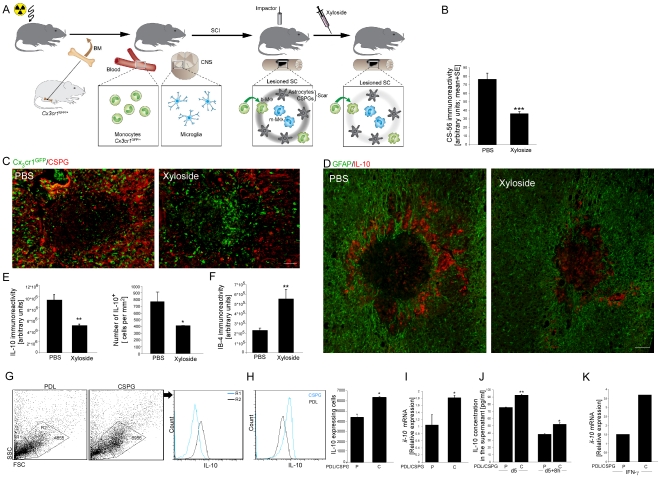
The glial scar component chondroitin sulfate proteoglycan determines the resolving/anti-inflammatory phenotype of the encountering monocytes.(A) Schematic illustration showing the experimental design. Spinal cord-injured [Cx3cr1GFP/+>wt] BM chimeras were subjected to spinal cord injury 8 weeks following BM transplantation. Immediately post injury, mice were treated with PBS or xyloside, an inhibitor of CSPG production, twice a day for 5 consecutive days. (B) Quantification of CSPG immunoreactivity at the lesioned spinal cord following treatment with xyloside, as assessed immediately after the last injection (Student's t-test; ***p<0.001). (C) Labeling of spinal cord sections for detection of CSPG (red) and GFP (green). Inhibition of CSPG synthesis disrupted the spatial compartmentalization of the infiltrating monocytes (GFP+), which are now located at the epicenter of the lesion. (D) Representative pictures of IL-10-expressing cells (red) and their location relative to the lesion epicenter, demarcated by GFAP expression (green), at day 7 post injury. Xyloside treatment abolished expression of this anti-inflammatory cytokine at the margins. (E) Quantitative analysis of IL-10 immunoreactivity (left panel, Student's t-test; **p = 0.004) and number of IL-10 expressing cells (right panel, Student's t-test; *p = 0.04), at day 7 post injury, in 2 mm2 isolated tissue sections, including lesion site, margin and surrounding parenchyma. (F) Quantification of activated microglia/MΦ according to IB-4 immunoreactivity (Student's t-test; **p = 0.007), as measured at day 14 post injury in 2 mm2 tissue sections, including lesion site, margin and surrounding parenchyma. (G–K) In vitro cultures of naïve CD115+ monocytes seeded on poly-D-lysine (PDL) or CSPG-coated flasks (3–4 cultures per group were analyzed in each experiment). The results presented are representative of several independent experiments performed. (G, H) Flow cytometric analysis for intracellular expression of IL-10. Two populations that differed in their size and granularity were identified (R1, R2), expressing differential levels of IL-10. CSPG seeded monocytes became enriched with the R2 population, which expressed higher levels of IL-10 (Student's t-test; *p = 0.025). (I, J) Cultures were harvested for analysis of Il10 gene expression by Real-Time PCR (I; Student's t-test; *p = 0.05), and the supernatants analyzed by ELISA for IL-10 protein expression (J; Student's t-test; **p = 0.0021; following replacement of media *p = 0.015). (K) Higher Il10 mRNA expression was observed in the CSPG coated dish even in the presence of IFN-γ, indicating that CSPG is a strong inducer of the resolving phenotype, even under pro-inflammatory/M1-skewing conditions. Scale bar; 50 µm. y-axis error bar represents SEM.